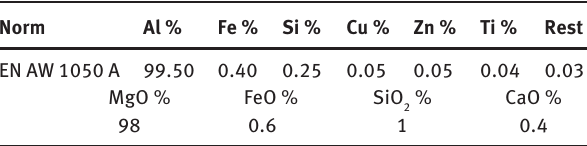
Table 1 Chemical compositions of matrix material Al and reinforce- ment element MgO.